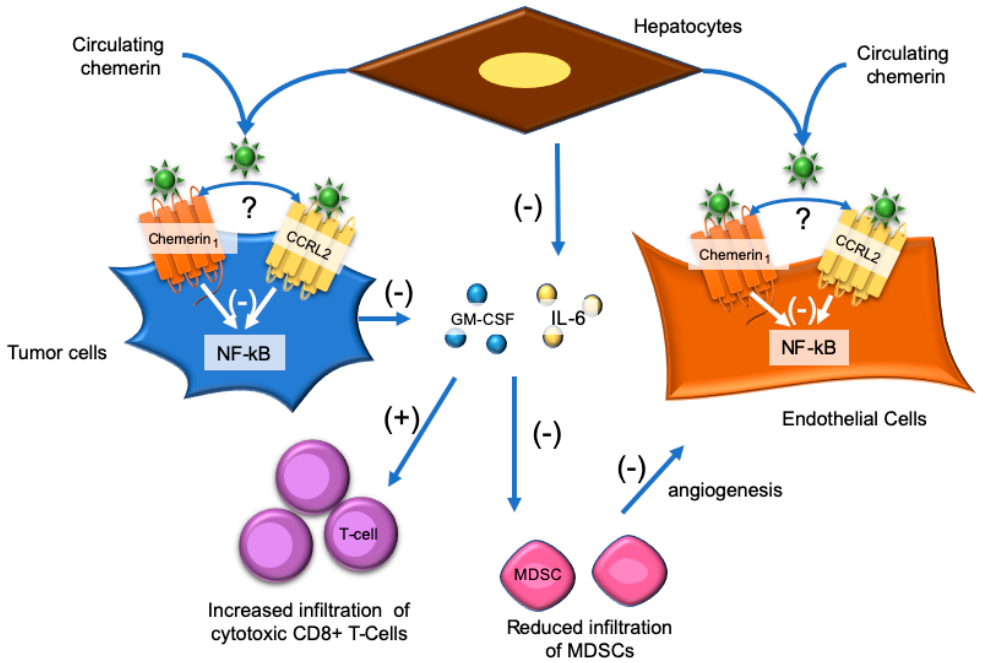
Figure 4. Chemerin has immune-mediated tumor-suppressive e ff ects in hepatocellular carcinoma. Systemic or hepatocyte-secreted chemerin interacts with chemerin 1 and CCLR2 on hepatocellular carcinoma cells and endothelial cells to inhibit nuclear factor kappa B (NF- κ B) signaling. By unknown mechanisms, this leads to reduced secretion of granulocyte-macrophage colony-stimulating factor (GM-CSF) from tumor cells and IL-6 from hepatocytes. In turn, this leads to reduced tumor infiltration of immunosuppressive and pro-angiogenic myeloid-derived suppressor cells (MDSCs) and increased infiltration of cytotoxic CD8+ T-cells. It is unknown (?) how and if CCRL2-bound chemerin interacts with chemerin 1 . (-) = Reduction or suppression of a normal pathway and (+) Increase of a normal pathway.